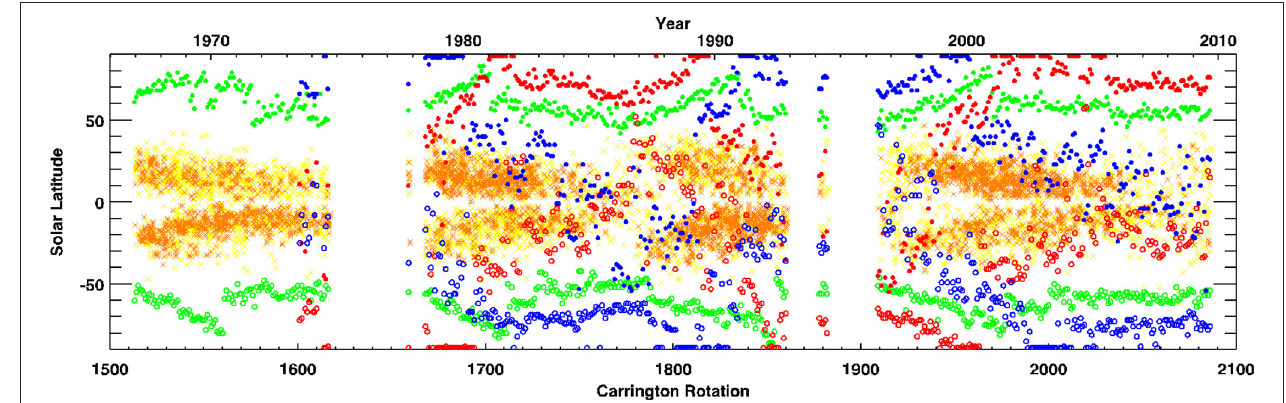
FIGURE 7 | Butterfly-type plot of all of the McA data processed to date starting with CR 1513 in October 1966 and ending with CR 2086 in July 2009. The Year scale is at the top and the CR scale at the bottom. This plots for each CR all sunspots (orange), the poleward-most filament boundaries (green), and the poleward-most CH boundaries (red and blue). As in Figure 6A , closed (open) circles indicate the most northward (southward) extensions of CH boundaries for each CR, and red and blue indicate magnetic